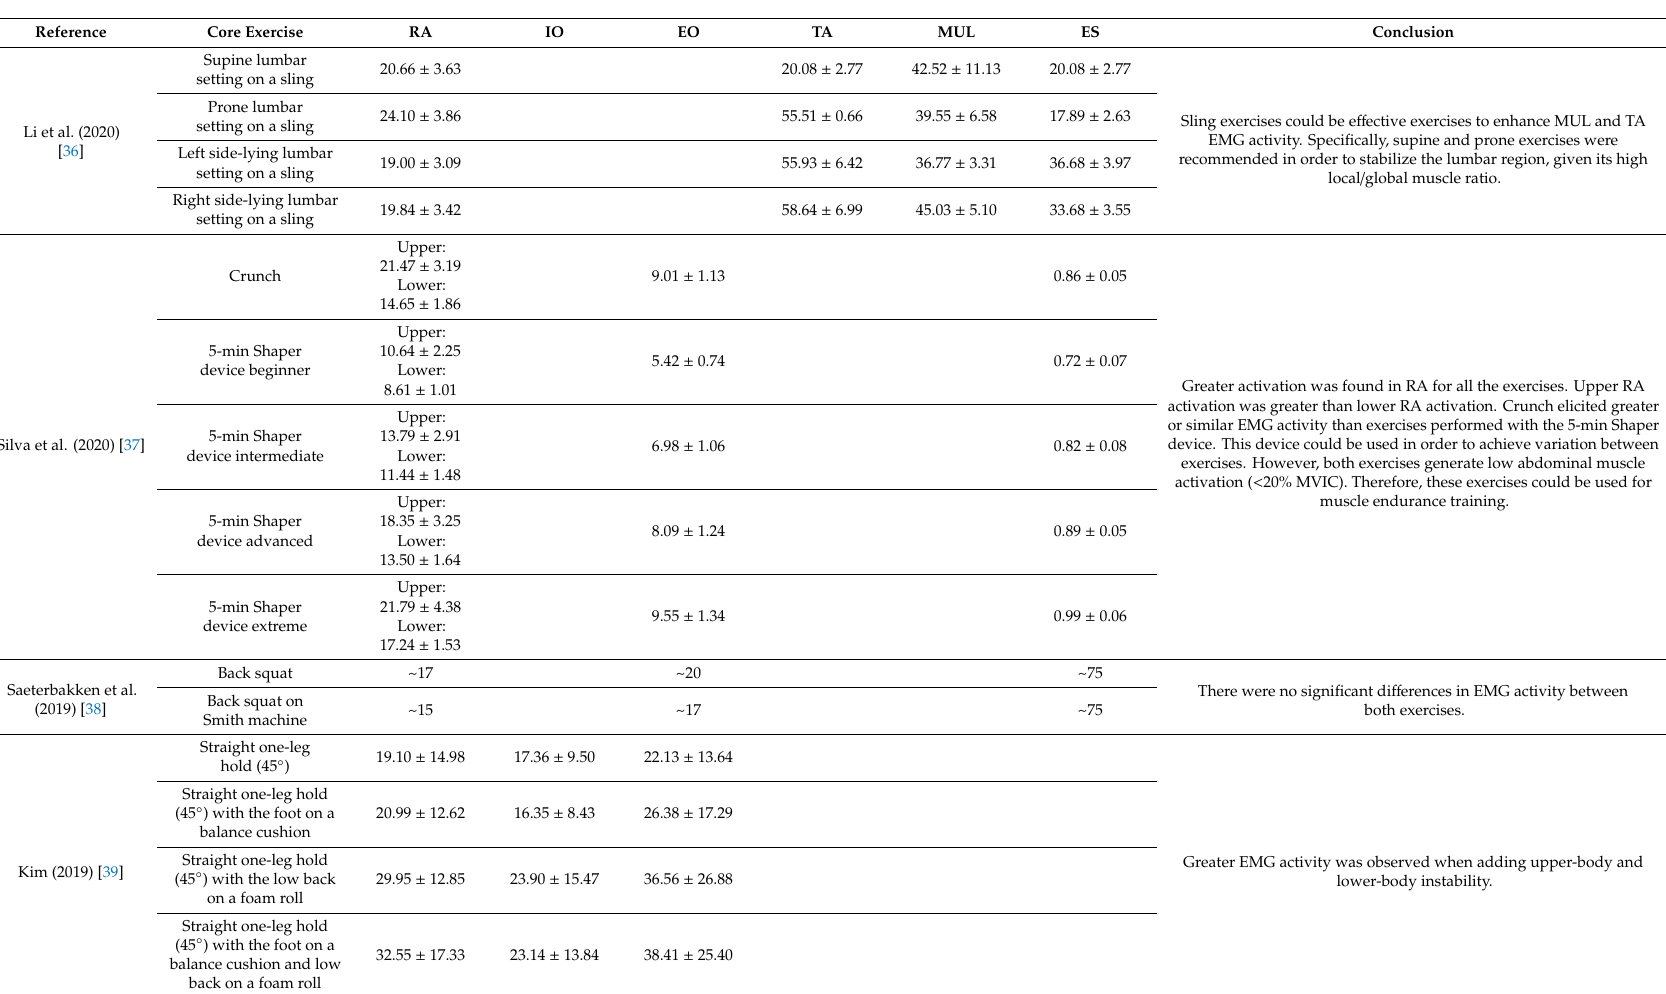
Table 3. Descriptive statistics of electromyographic activity (expressed as percentage of maximum voluntary contraction, % MVIC) in each study by exercise.